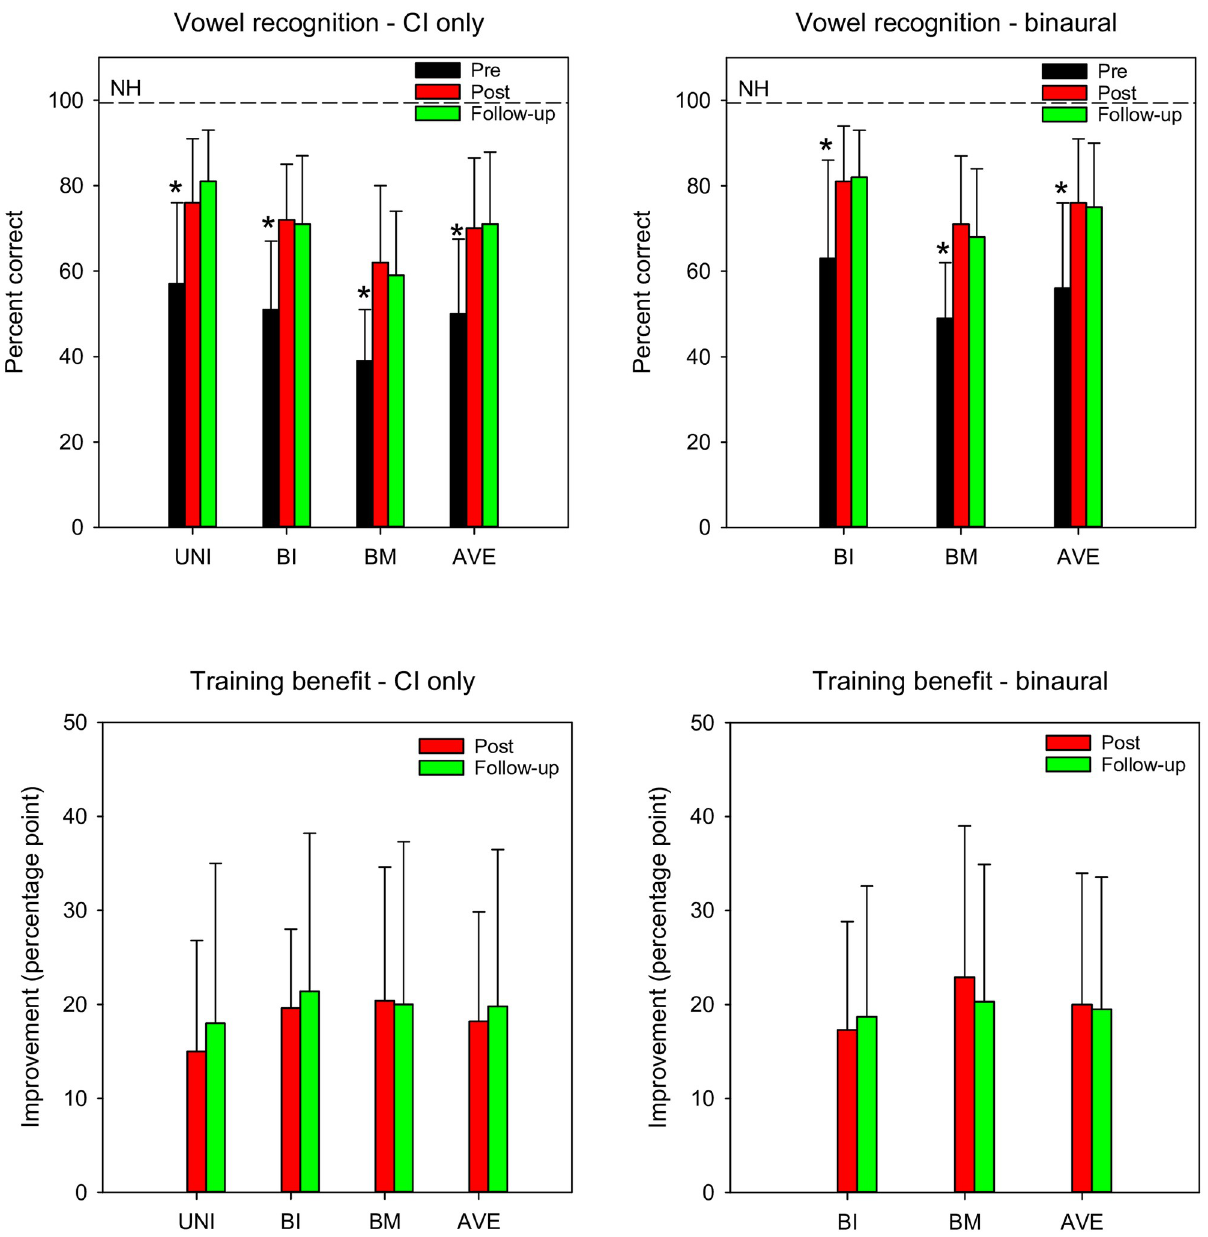
Fig 3. Mean vowel recognition and training benefit. The top panels show vowel recognition scores with CI-only (left) and binaural listening (right); the dashed lines show mean NH performance. The bottom panels show training benefit with CI-only (left) and binaural listening (right). The error bars show the standard deviation. The asterisks show significantly different scores. (bottom) with CI-only (left) and binaural listening (right). LMM analyses were performed on CI-only consonant score data, with group (unilateral, bimodal) test point (pre, post, follow- up), and test run (1, 2, 3) as fixed factors and participant as a random factor. Results showed significant main effects for test point [F(2, 56) = 48.1, p < 0.001], but not for test run [F(2, 56) = 0.7, p = 0.502], or group [F(1, 8) = 4.8, p = 0.060]; there were no significant interactions. For unilateral, bilateral, and bimodal CI users, post-hoc Bonferroni pairwise comparisons showed